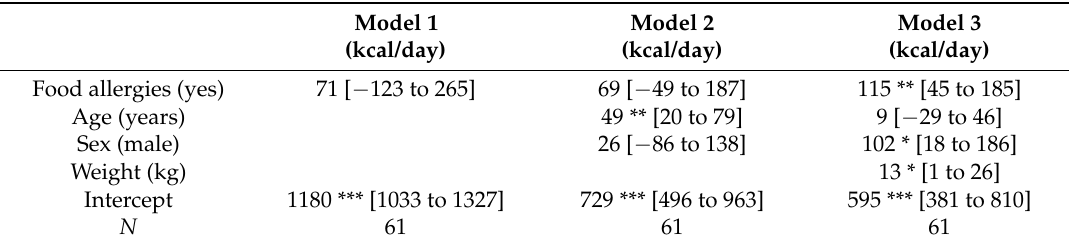
Table 4. Association between food allergies and resting energy expenditure (REE): 25th percentile regression equations. Model 1 Model 2 Model 3 (kcal/day) (kcal/day) (kcal/day) Food allergies (yes) 58 [ − 111 to 227] 37 [ − 92 to 165] 13 [ − 85 to 111] Age (years) 68 *** [42 to 94] 23 [ − 2 to 47] Sex (male) 120 [ − 5 to 246] 81 ** [20 to 141] Weight (kg) 14 *** [9 to 19] Intercept 926 *** [823 to 1029] 402 ** [153 to 650] 410 *** [252 to 569] N 61 61 61